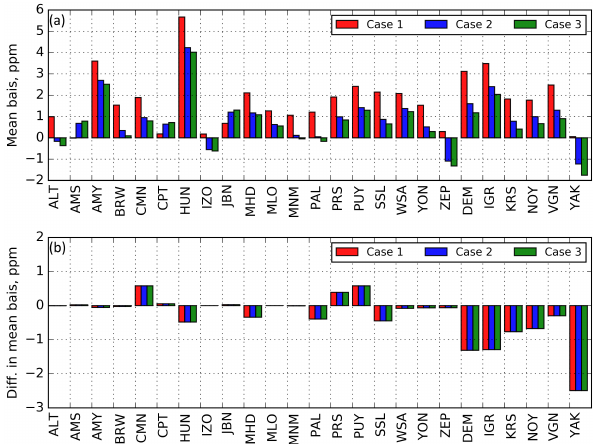
Figure 4. (a) Mean bias for the CO 2 concentrations simulated with the coupled model, (b) difference in mean bias due to the applica- tion of the Lagrangian component (for positive bias – the most usual case – negative values mean the results of the coupled model are bet- ter than those of the Eulerian model alone) at the selected WDCGG and JR-STATION locations for 2009–2010. The definitions of the cases 1–3 are in Table 1.